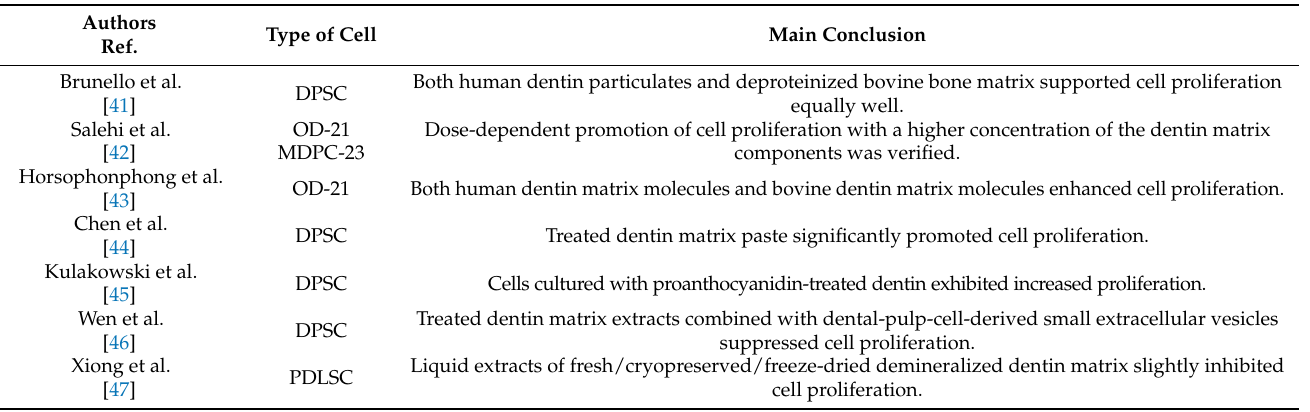
Table 1. Treated dentin matrix and its derivatives’ effects on cell proliferation.